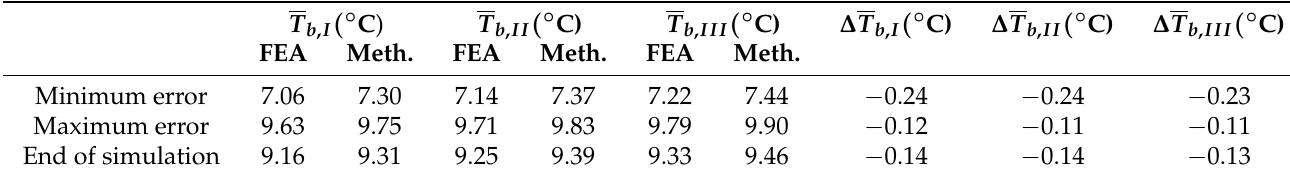
Table 6. Errors of borehole wall temperatures during the 7-day period.